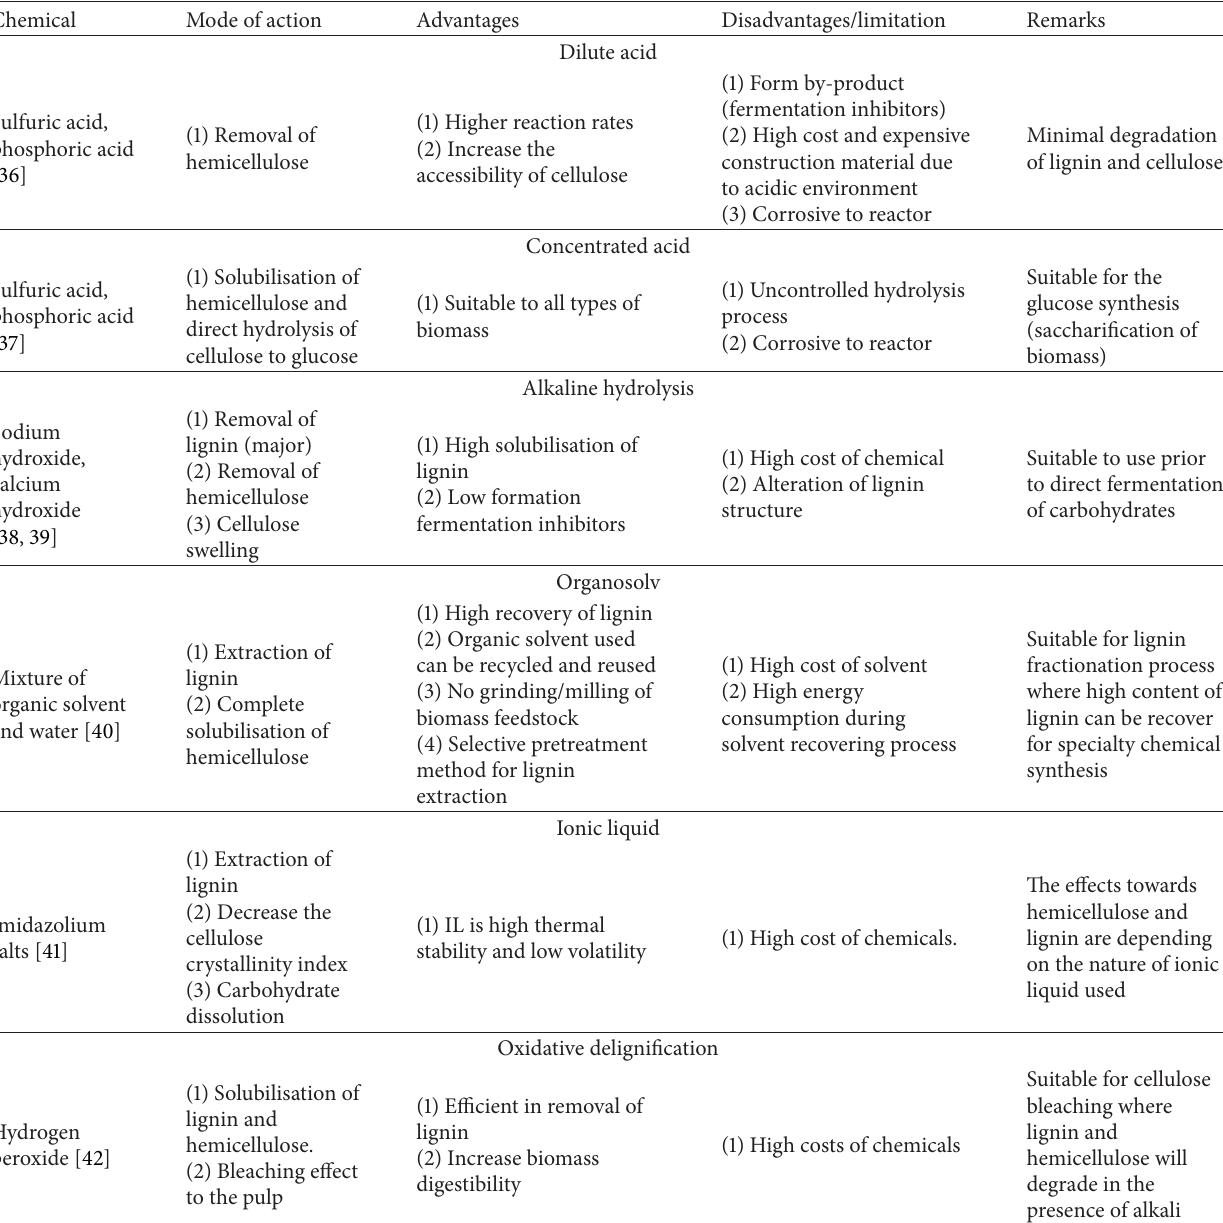
Table 3: Functionality, advantages, and limitations for each chemical